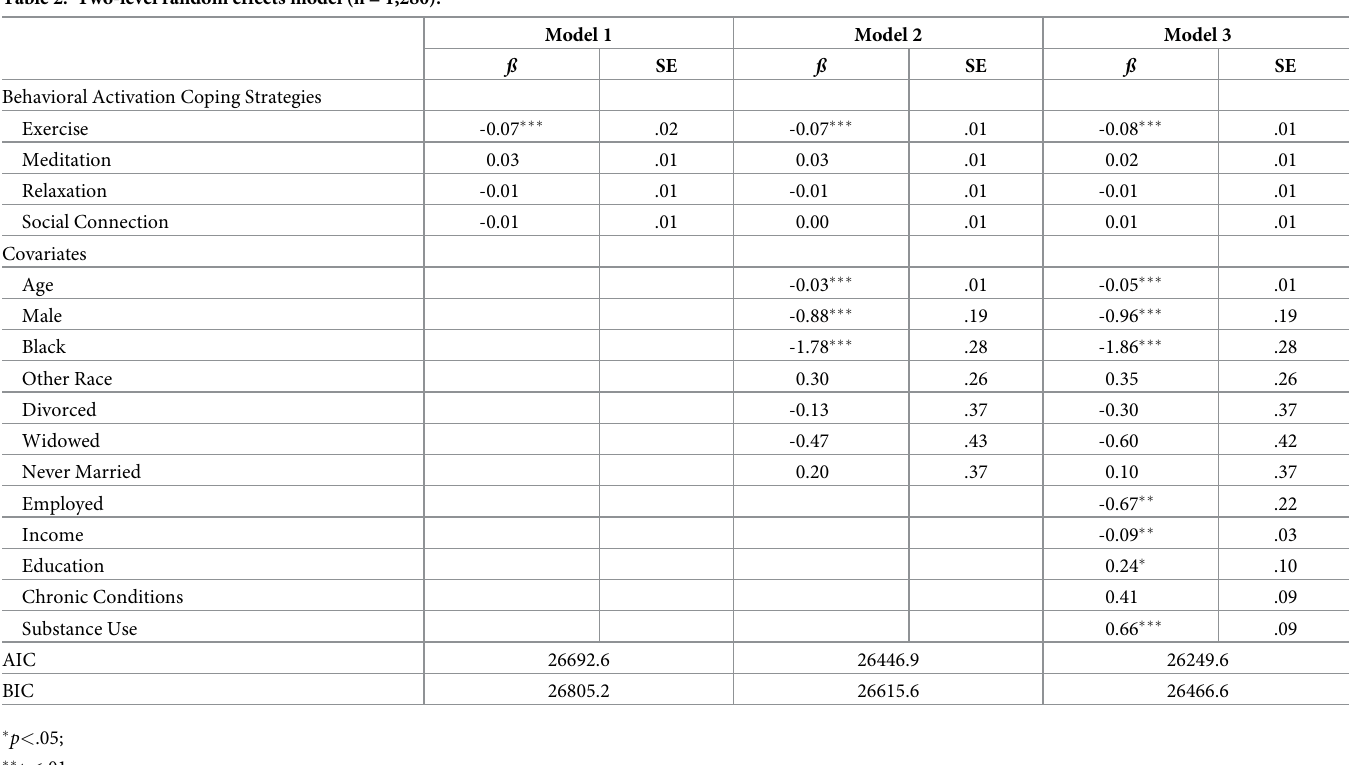
Table 2. Two-level random effects model (n =